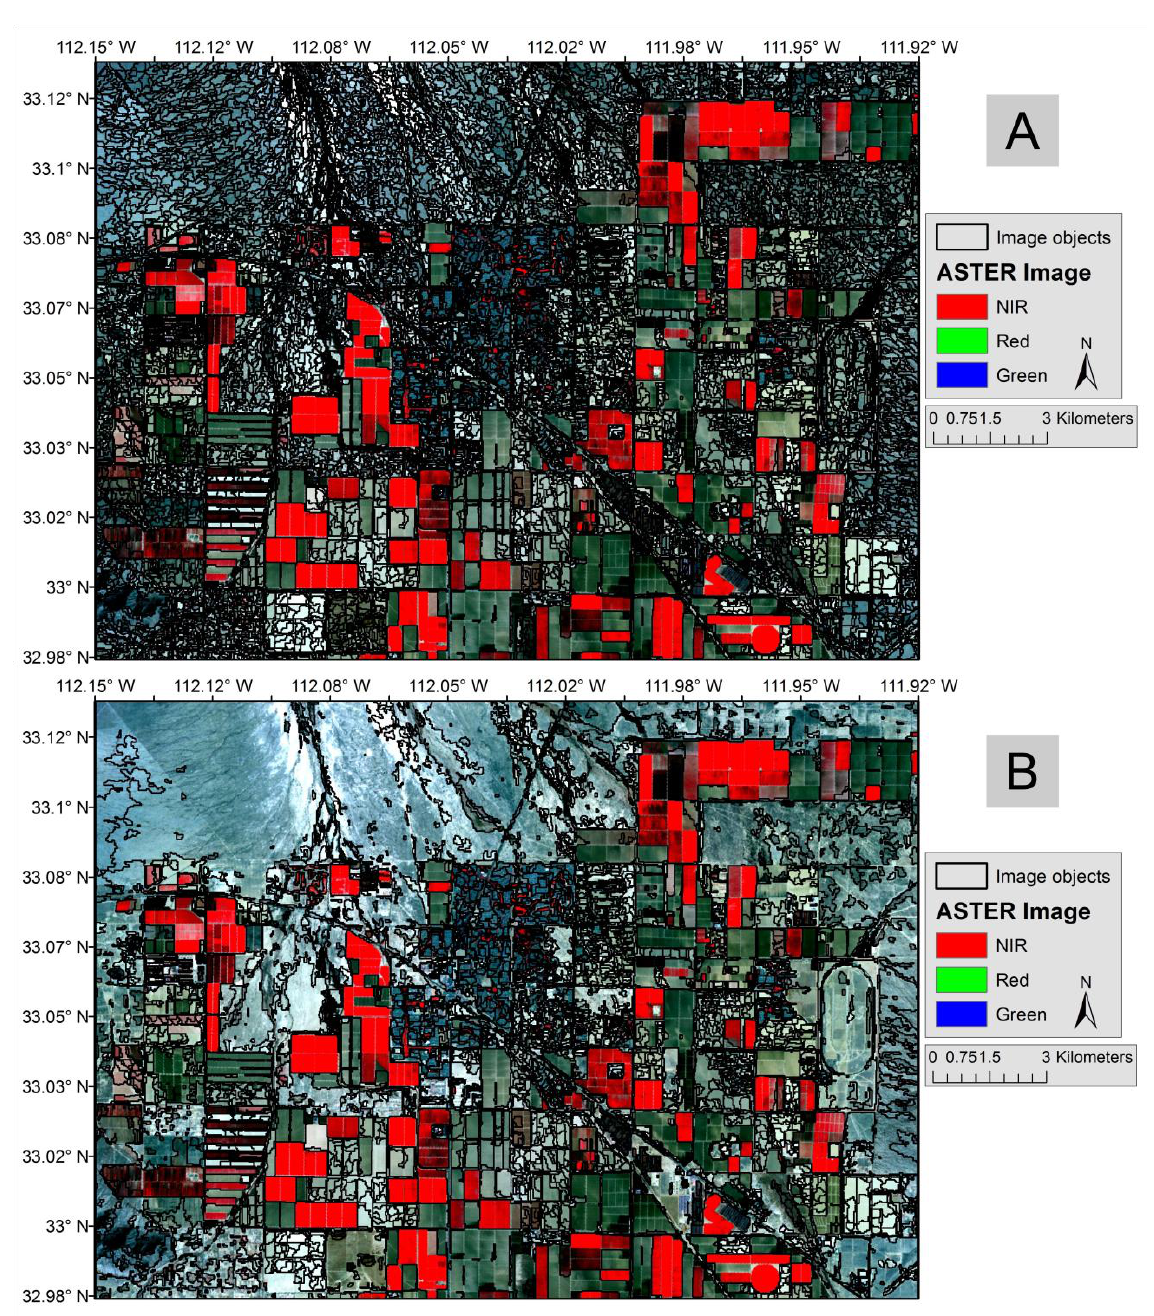
Figure 5. Comparison of objects before ( A ) and after ( B ) a merge of high